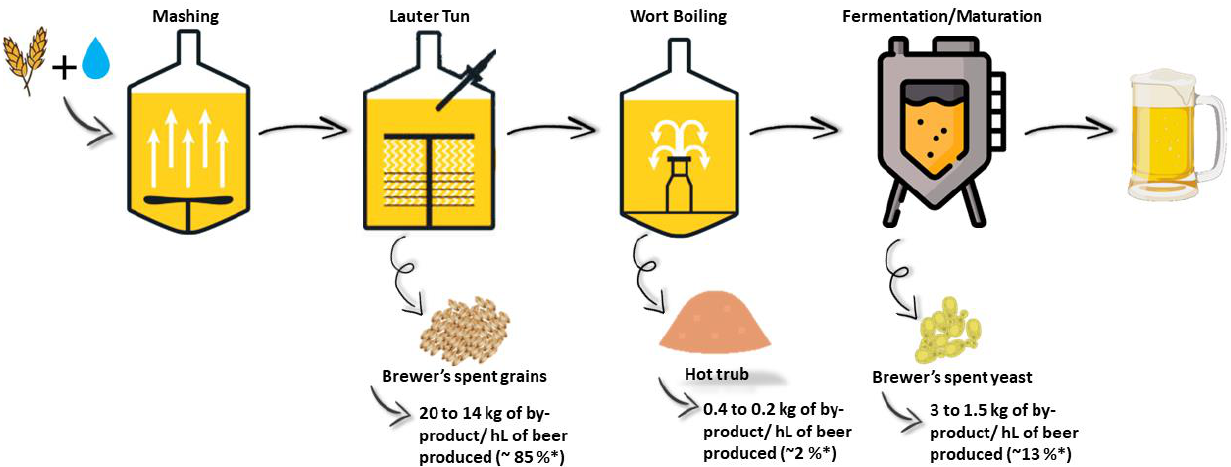
Figure 1. Scheme of beer manufacturing coupled with by-product generations per stage according to data from Mathias et al. [4]. * Percentage related to the volume total of by-products generated in all steps.